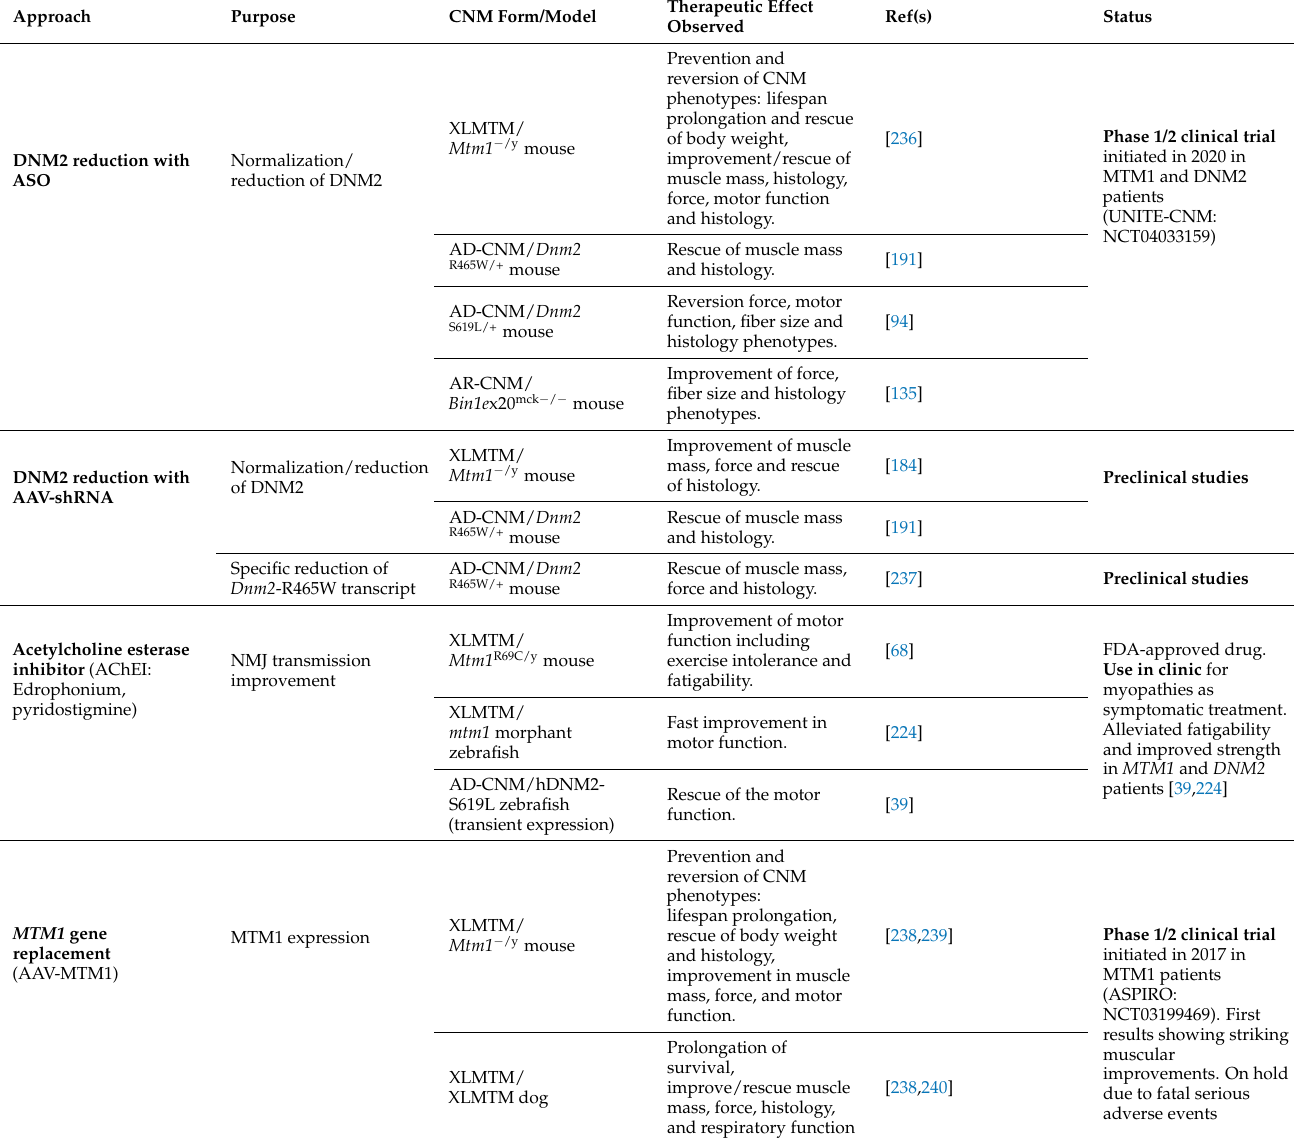
Table 6. List of therapeutic approaches and